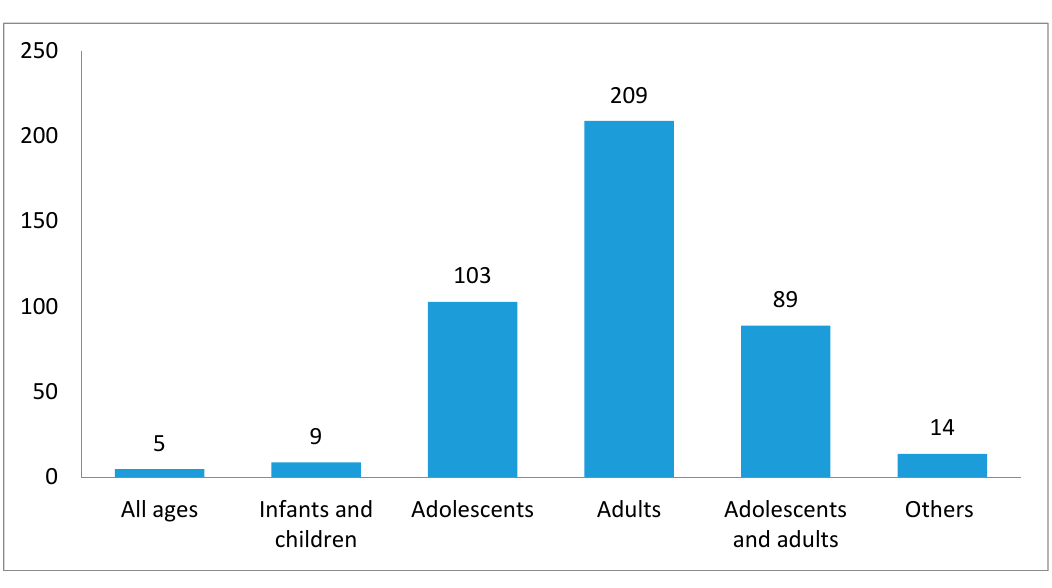
Figure 7. Characteristics of study population for Tobacco Control Research in SSA, (up to February 2017; n = 429).